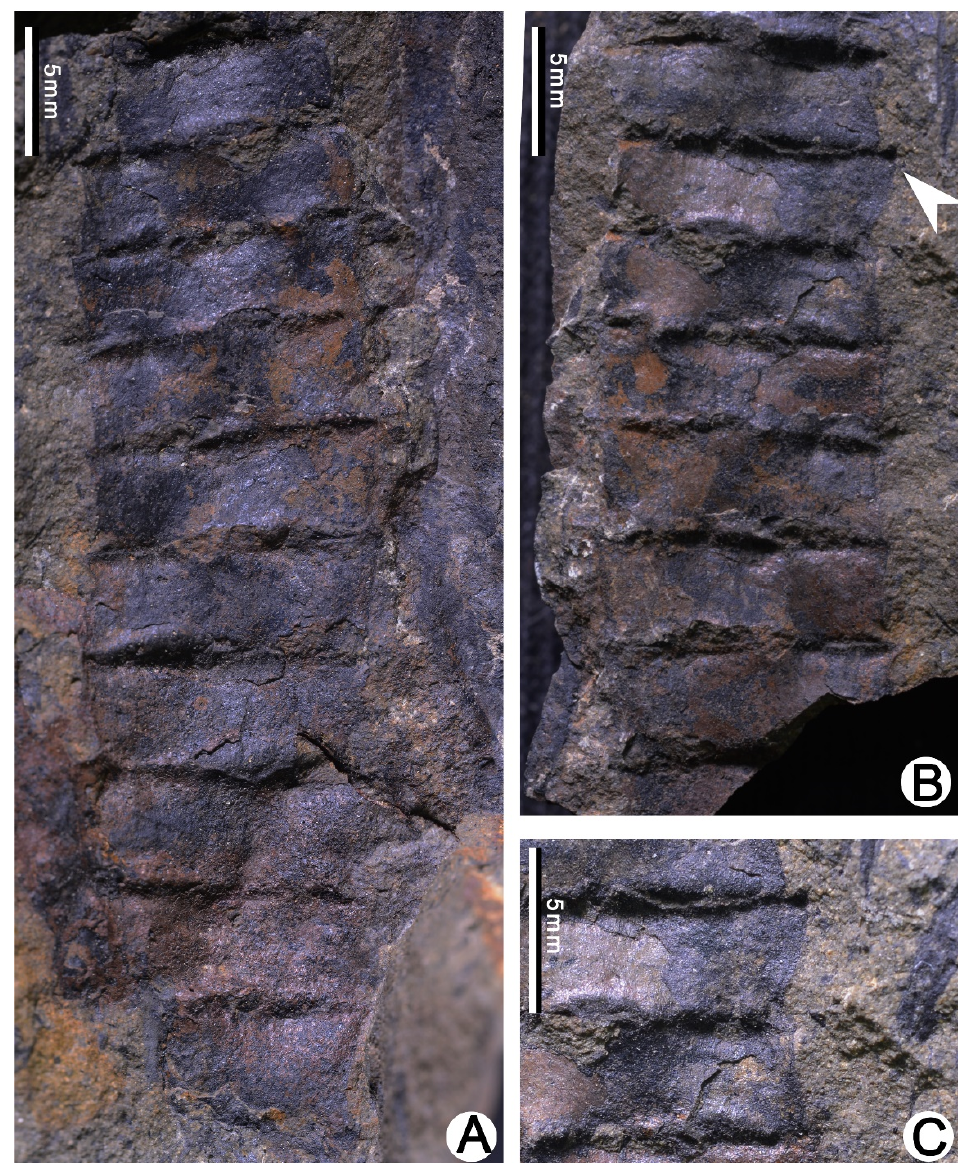
Figure 1. Barsassia ornata [17] from the Middle Devonian Hujiersite Formation, Hoxtolgay, West Junggar, Xinjiang, China. ( A ) A bifurcated leafy stem with obvious step-like structure on the surface. PB23702. ( B ) Neotype. Two stems with imbri- cately and tightly arranged leaves, leaf shape in a variety ranging from fan-shaped (arrow 1), fan-shaped with short awl- shaped tips (arrow 2), and rectangular-shaped (arrow 3) in surface view. Arrow 6 indicates the step-like stem. PB23703. ( C , D ) A three-dimensional cast of the stem with tipped leaves (arrows), one and its reverse side PB23704. ( E ) Enlargement of a portion of leafy stem indicated by arrow 2 in A, showing the step-like structure of the stem and dots on leaf surface (arrow).